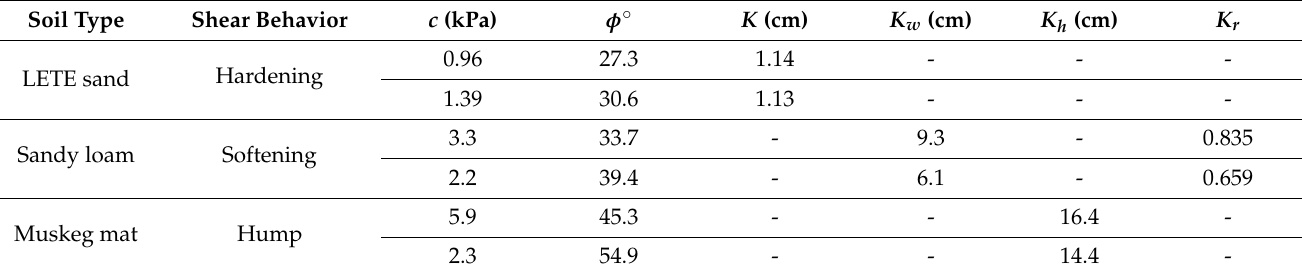
Table 1. Soil parameters for the evaluation of soil thrust of continuous tracks obtained by Wong [3].